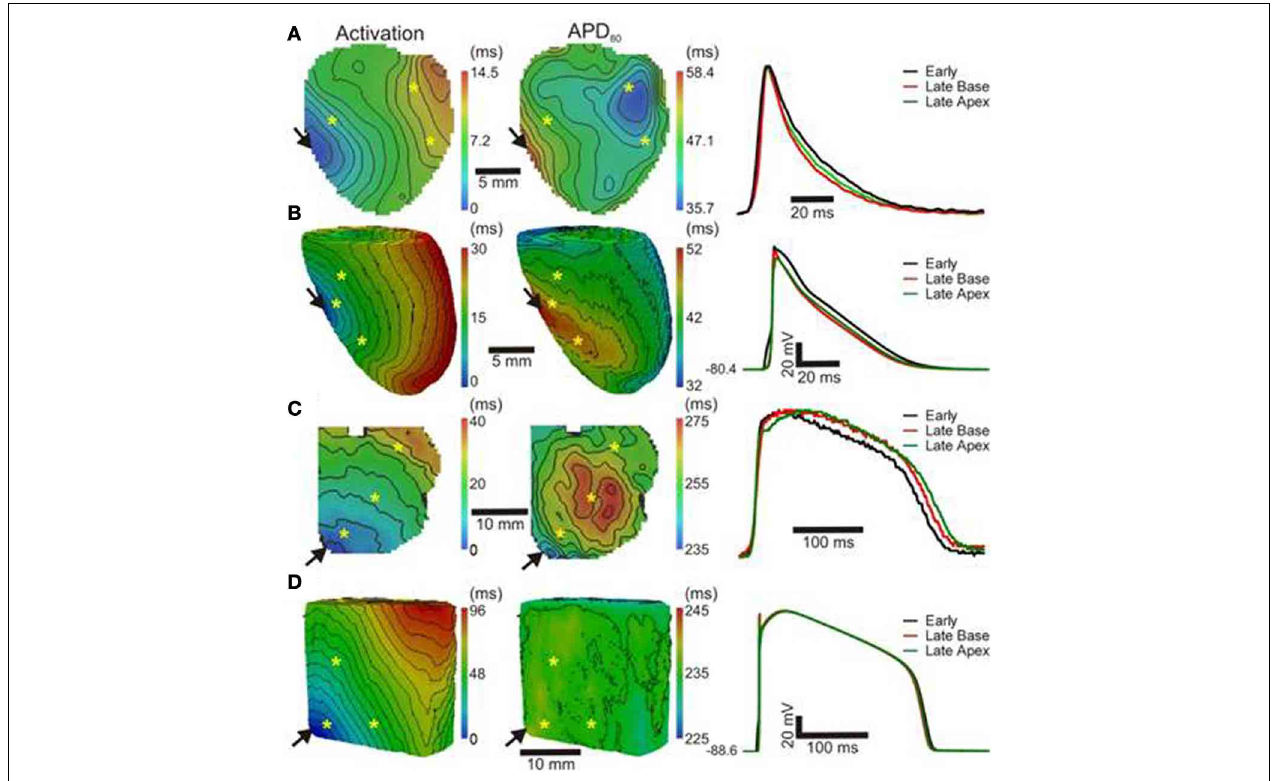
FIGURE 1 | AT and APD maps from rat and pig myocardium. Rat ventricles were paced from the anterior insertion sites (arrows) in experiments (A) and simulations (B) . Pig left ventricular wedge preparations were paced from the apex in experiments (C) and simulations (D) . Panels